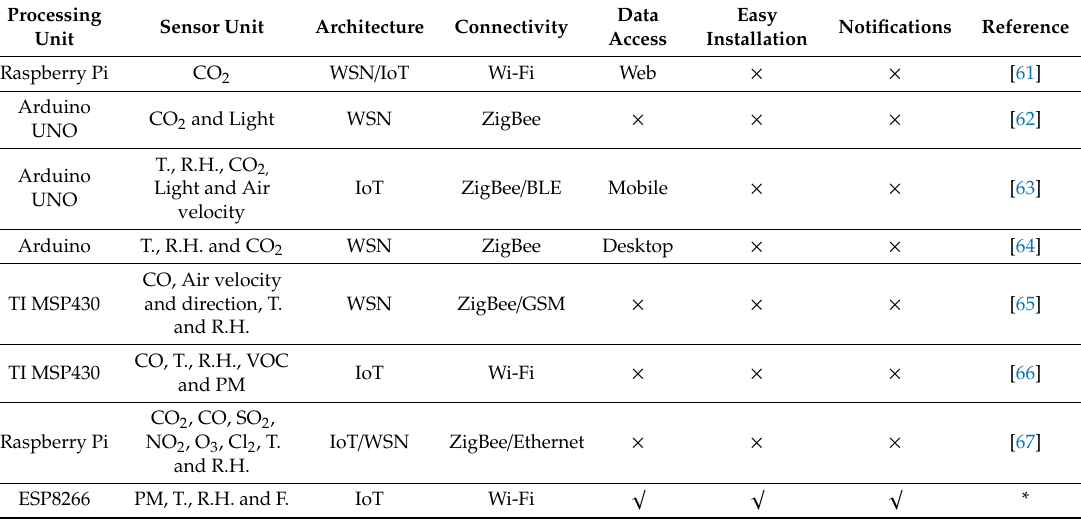
Table 1. Indoor environmental monitoring system